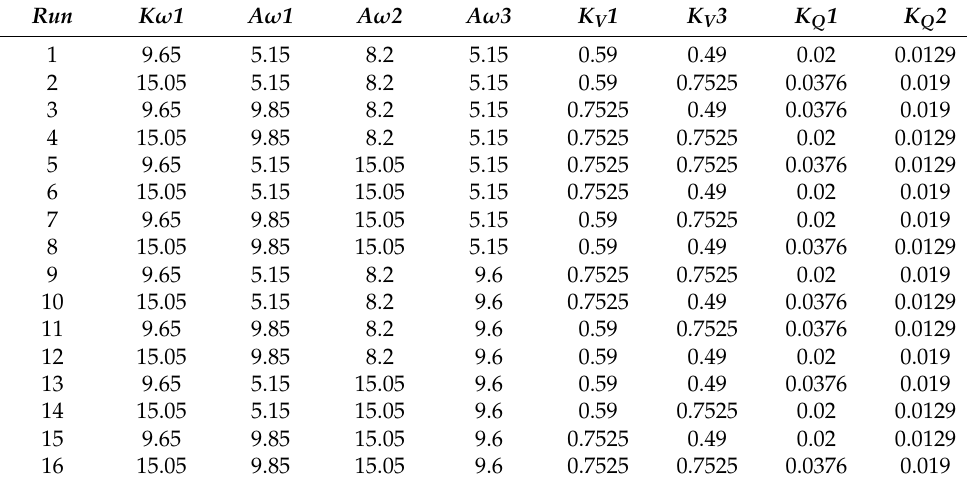
Table 6. Fractional factorial design with resolution IV.